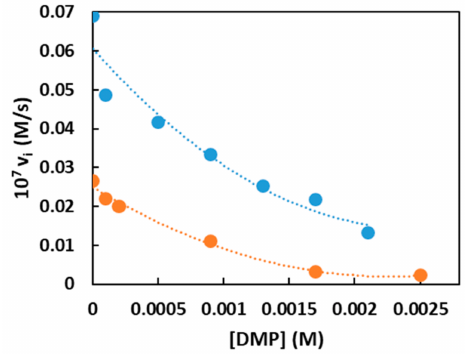
Figure 4. Inhibition kinetics obtained for catalysts AuNP1 and AuNP2 by progressive addition of dimethylphosphate (DMP). Conditions: [AuNP], (in thiol units) = [Zn(II)] = 2.5 × 10 − 5 M, [EPPS, bu ff er] = 1.0 × 10 − 2 M, [HPNP] = 1.0 × 10 − 5 M; pH = 7.5, 40 ◦ C in H 2 O. Symbols code: AuNP1: Blue; AuNP2: